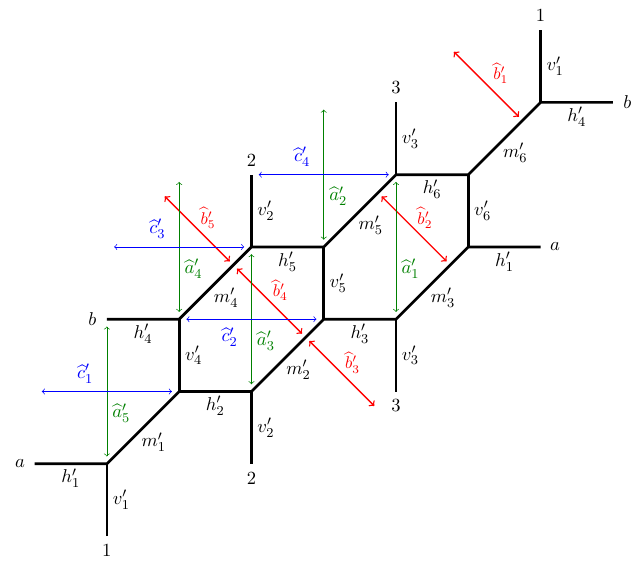
Figure 10 . Toric web diagram of X (1)